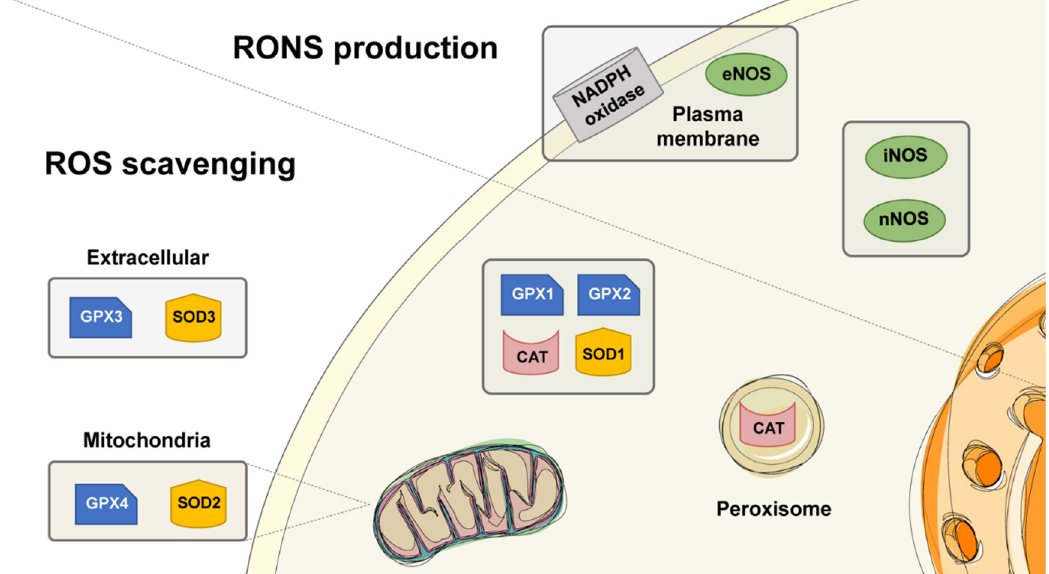
Figure 1. Cellular localization of the enzymatic systems related to oxidative stress.